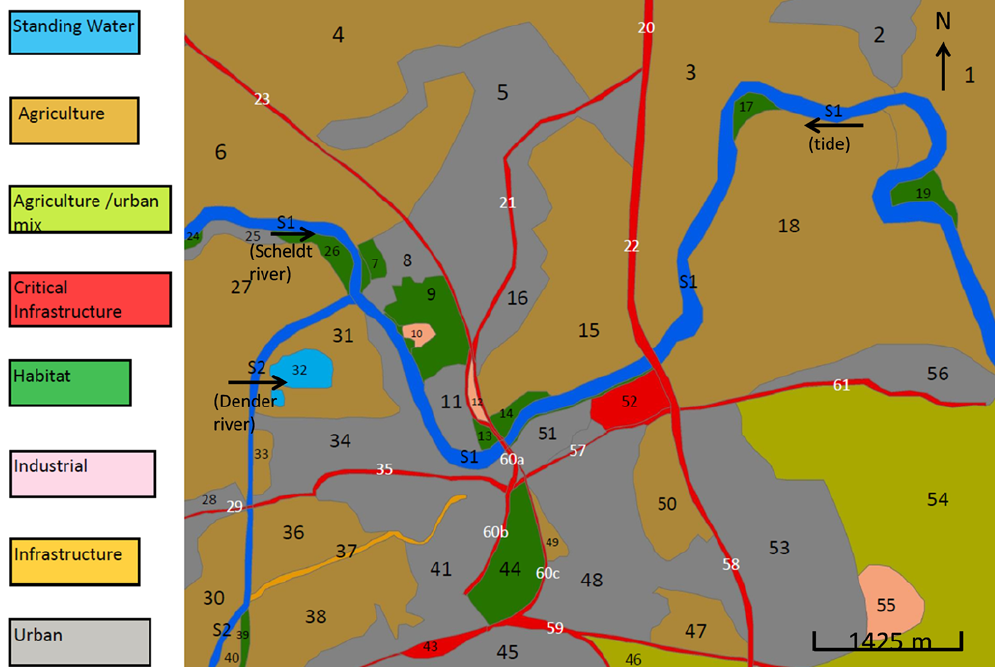
Fig. 4. Dendermonde flood system map for the maximum considered flood extent (100yr flood + 3m, planar water level, no defences) with numbered elements classified by land-use (Area A – flood system north of S1; Area B – flood system between S1 and S2; Area C – flood system south of S1, east of S2) (based on data from Google Earth). The regions collectively correspond to element “BE–UR3” in Fig. 3 (based on steps 1 and 2 of Methodology in Sect.